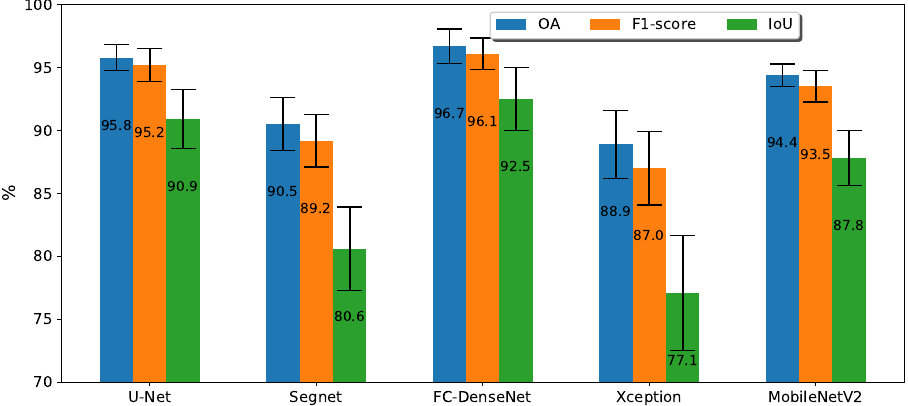
Figure 7. Mean of the overall accuracy (OA), F1, and IoU in the fivefold cross-validation for the all FCN